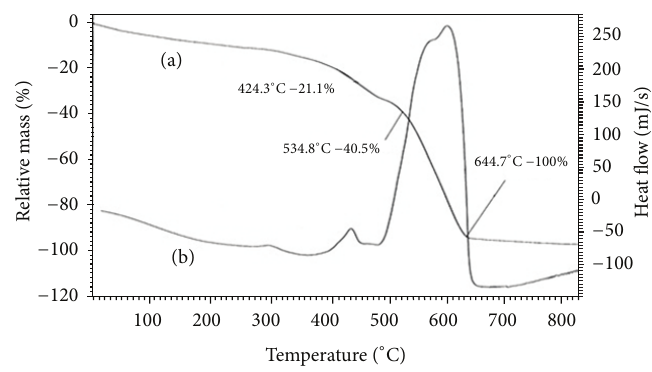
Figure 1: TG curve (a) and DTA curve (b) of